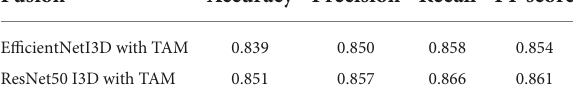
TABLE 5 Stress detection accuracy, precision, recall and F1-score by multimodality using different convolutional neural networks.